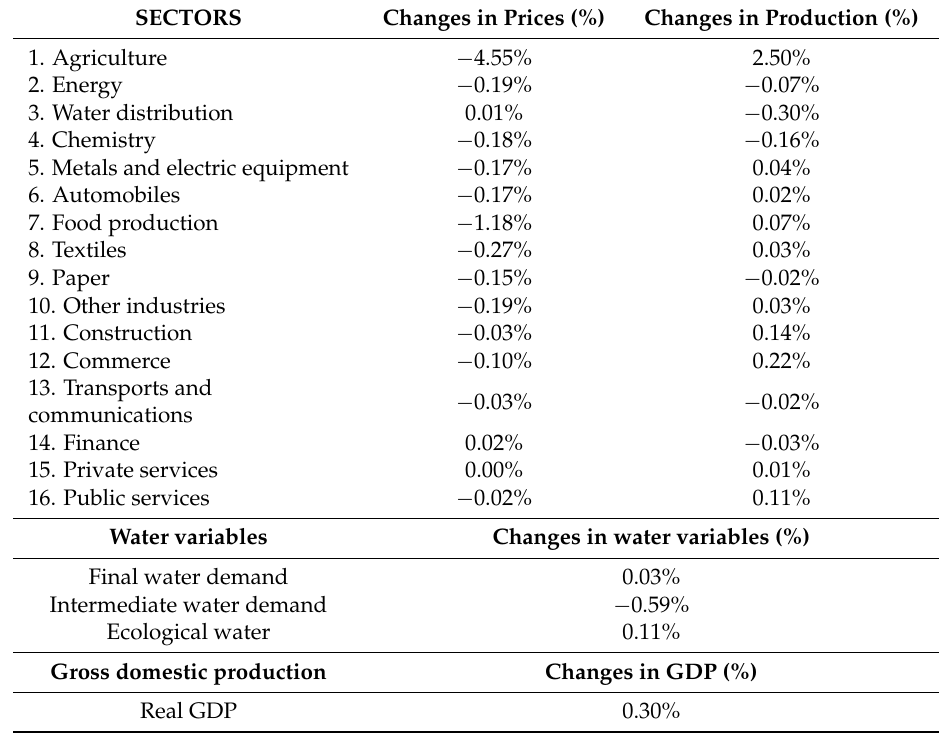
Table 3. Simulation 3: 25% increase in TPF of agriculture (with water